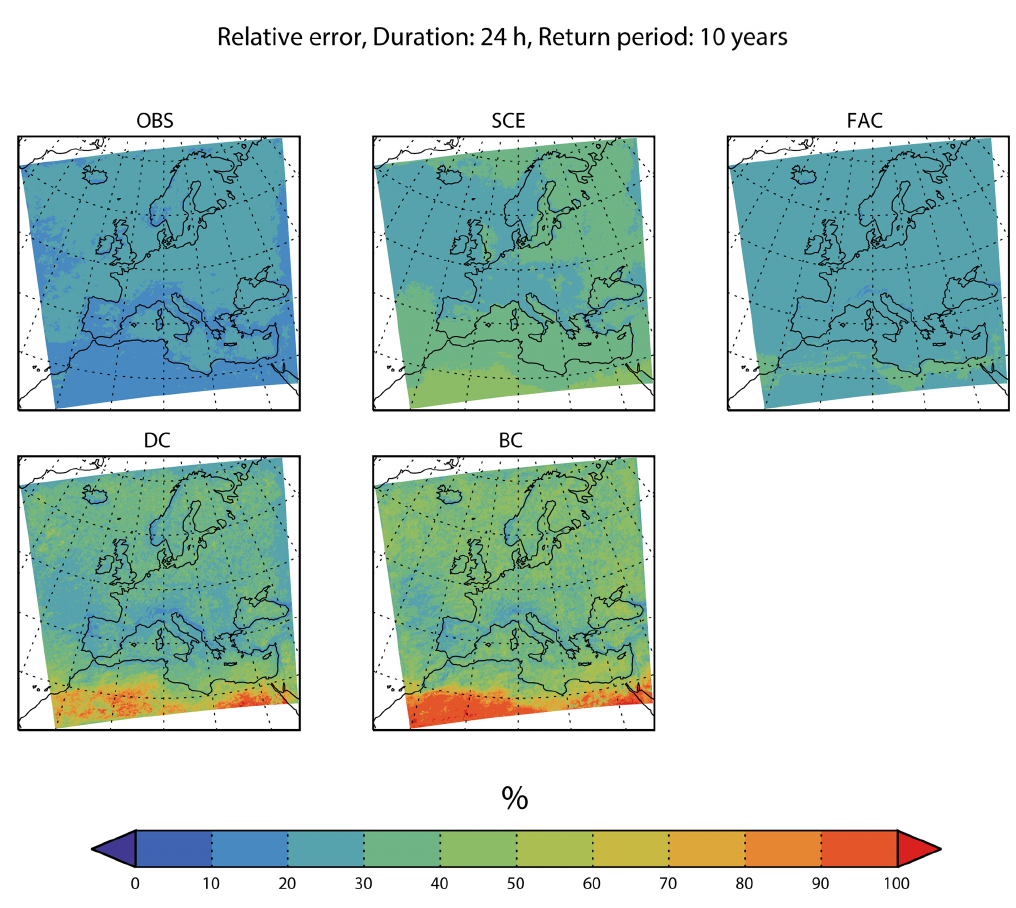
Figure 7. As in Fig. 5 but for a 24h